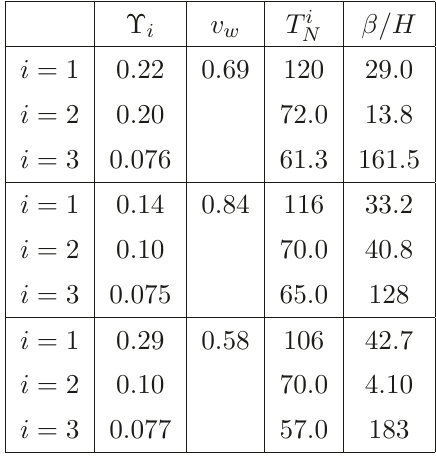
Table 1 . Inputs to relic gravitational wave spectrums for all four SM + singlet benchmarks. κ 1 κ 2 Λ α